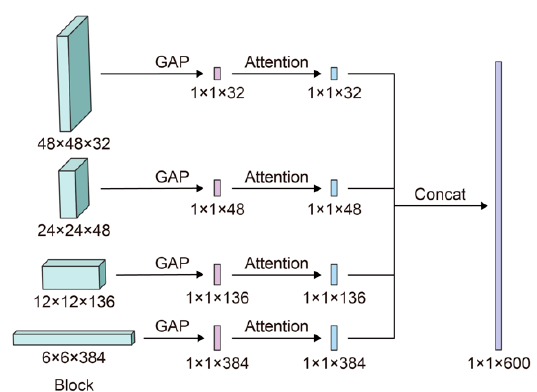
Figure 7. The approach to integrate the attention and FF mechanisms to EfficientNet-B3.